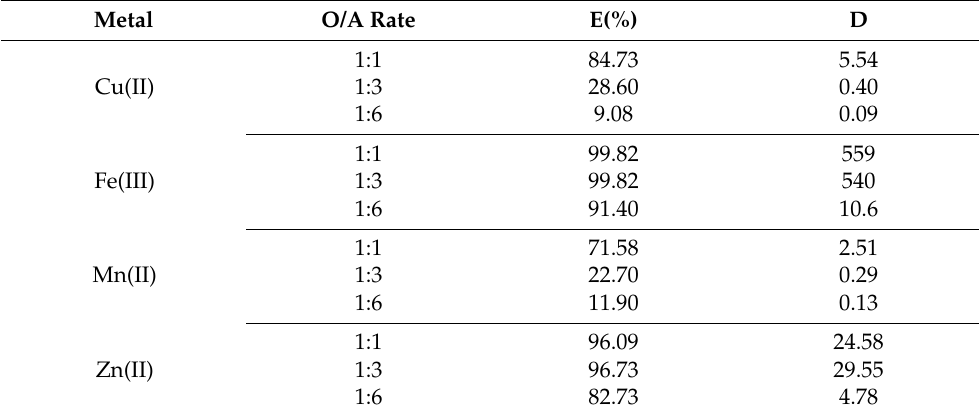
Table 3. Effect of O/A ratio on extraction efficiency and distribution ratio of the species.